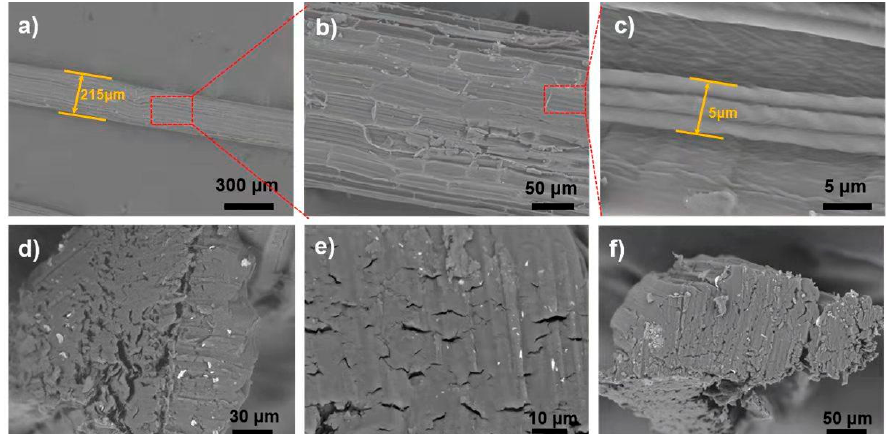
Figure 1. Scanning electron micrograph of different segments of raw sisal fiber: ( a ) Cross-sectional view of raw sisal fiber and visual demonstration of numerous microfibrils intertwined with each other. ( b ) SEM image of the red rectangular area selected in panel ( a ). ( c ) Magnified SEM view of the marked red rectangular area from panel ( b ). ( d – f ) Cross-sections of a raw sample with different magnifications.